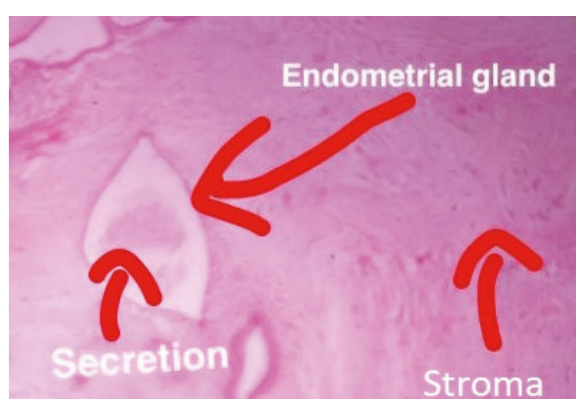
Figure 5: Histopathology of the specimen showing endometrial glands and stroma (H&E staining, magnification